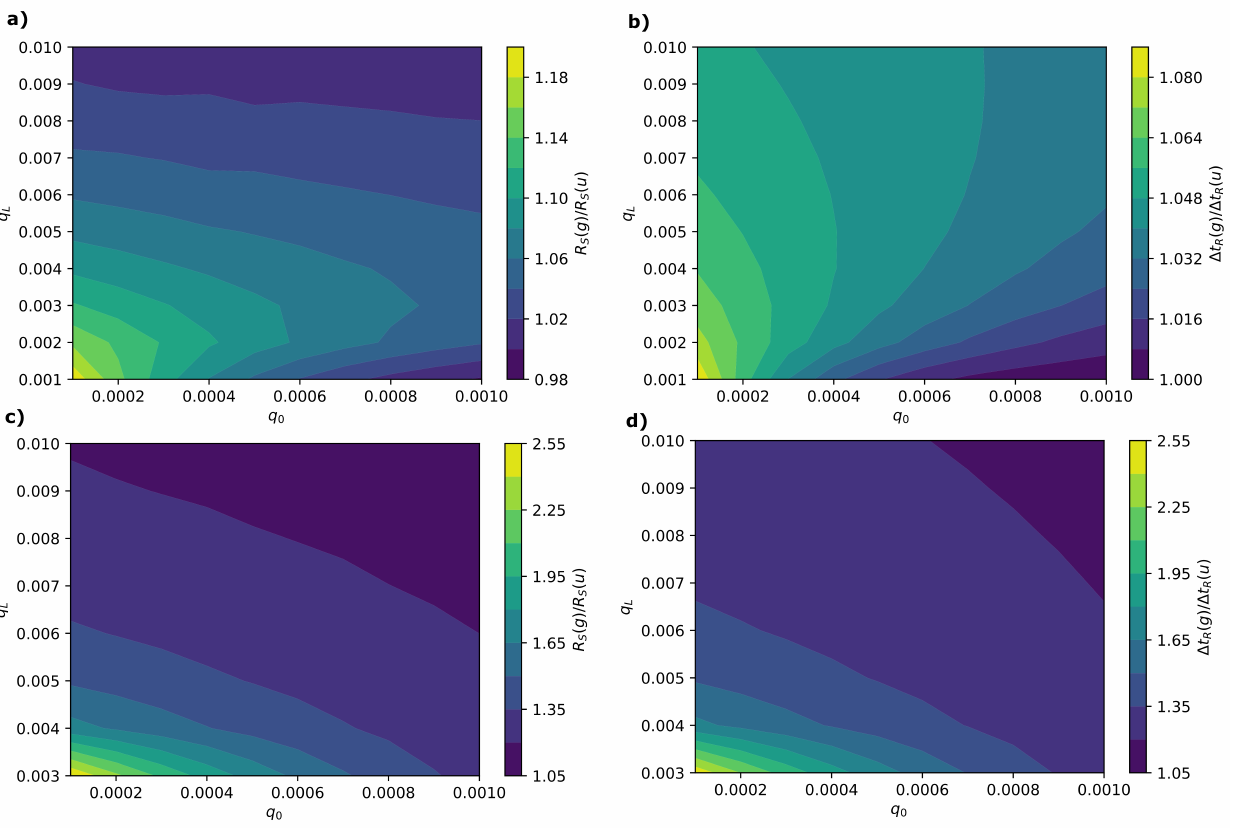
Figure 4. Ratios of resolutions ( a , c ) and retention time differences ( b , d ) for separations of mono1 - di1 ( a , b ) and mono2 - di2 ( c , d )